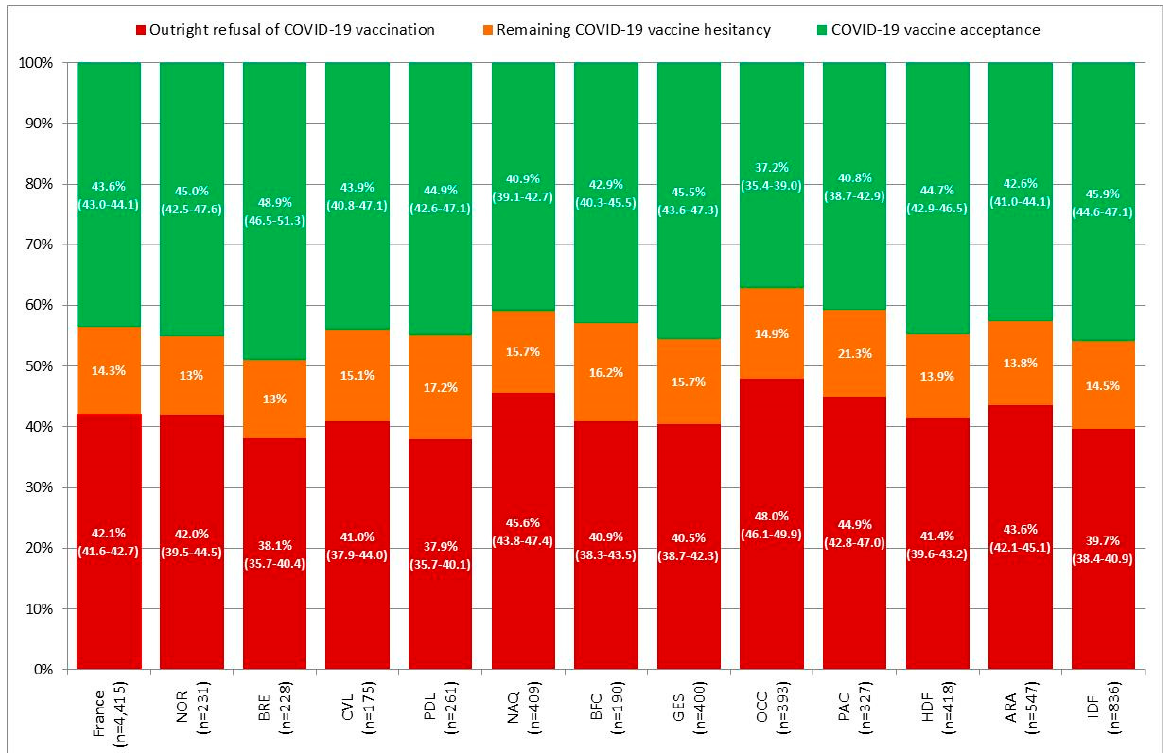
Figure 4. Acceptance of BioNTech vaccine predicted in the French working-age population, overall and by region (December 2020). Figure legend: Auvergne-Rhône-Alpes (ARA), Bourgogne-Franche-Comté (BFC), Bretagne (BRE), Cen-tre-Val de Loire (CVL), Grand Est (GES), Hauts-de-France (HDF), Ile-de-France (IDF), Normandie (NOR), Nouvelle-Aquitaine (NAQ), Occitanie (OCC), Pays-de-la-Loire (PDL), and Provences-Alpes-Côte-d’Azur (PAC). French regions of residency are ordered by detected SARS-CoV-2 prevalence.